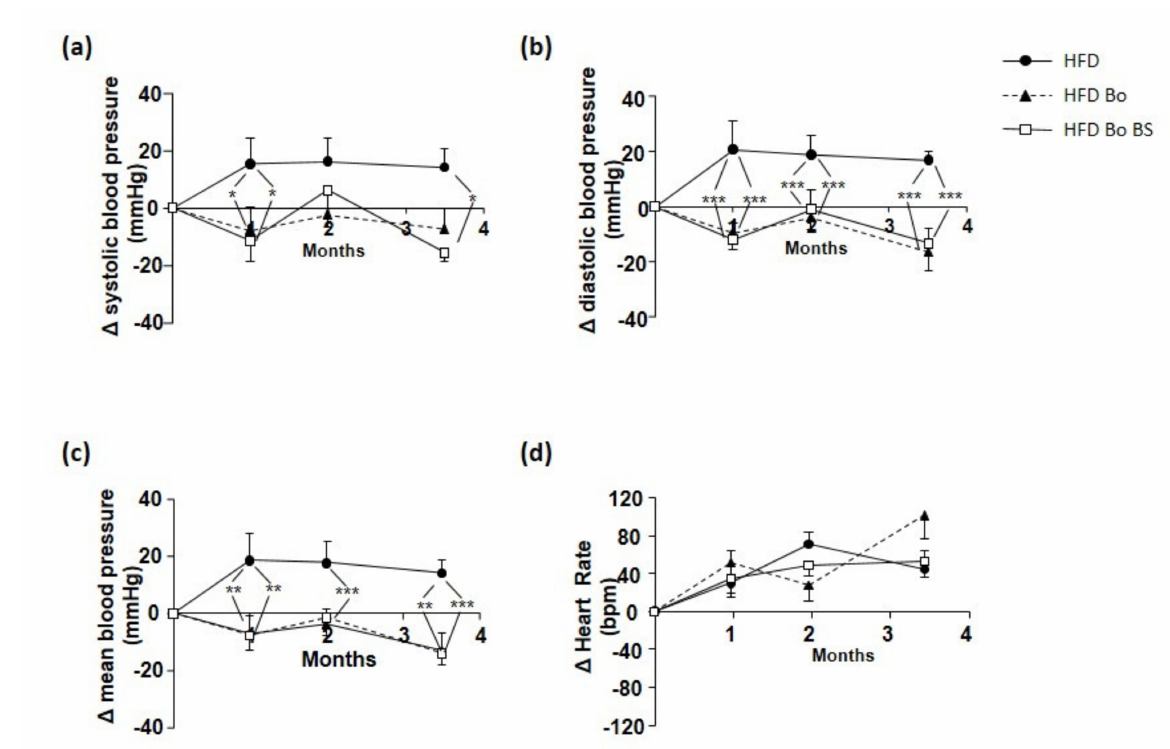
Figure 6. Carrot supplementation effects on hemodynamic parameters of ApoE − / − mice. Systolic ( a ), diastolic ( b ), mean ( c ) pressure, and heart rate ( d ) variations in mice receiving HFD (black circle, n = 8; 4 males and 4 females) or HFD supplemented with Bolero under standard condition (Bo, black triangle; n = 7; 5 males and 2 females) or Bolero under biotic stress condition (BoBS, black square; n = 6; 4 males and 2 females) throughout the 14 weeks of diet. Data were given as mean ± SEM. * p < 0.05, ** p < 0.01, *** p < 0.001 vs., HFD